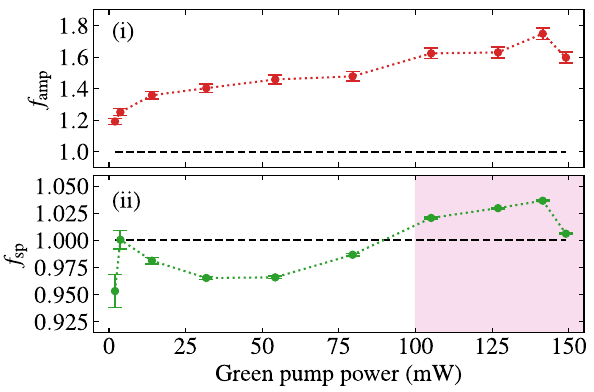
Figure 3: Amplification and spontaneous-emission factor as a function of green pump power. Error bars shown are one standard deviation range obtained by propagating the shot noise in spec- trometer counts for each pump powers. (i) f amp was extracted from raw data like the ones displayed in Figure 2 and measures the ampli fi cation of the red laser upon off-resonant pumping of nitrogen-vacancy (NV) centres. (ii) f sp measures the in fl uence of the red laser on the spontaneous emission of the NV centres and was obtainedbyintegrationofthebackgroundsignalsinthewavelength region of the inset of Figure 2 (ii). The black dotted lines indicate the reference line at unity, which corresponds to no difference in the output signal between the different pumping schemes.